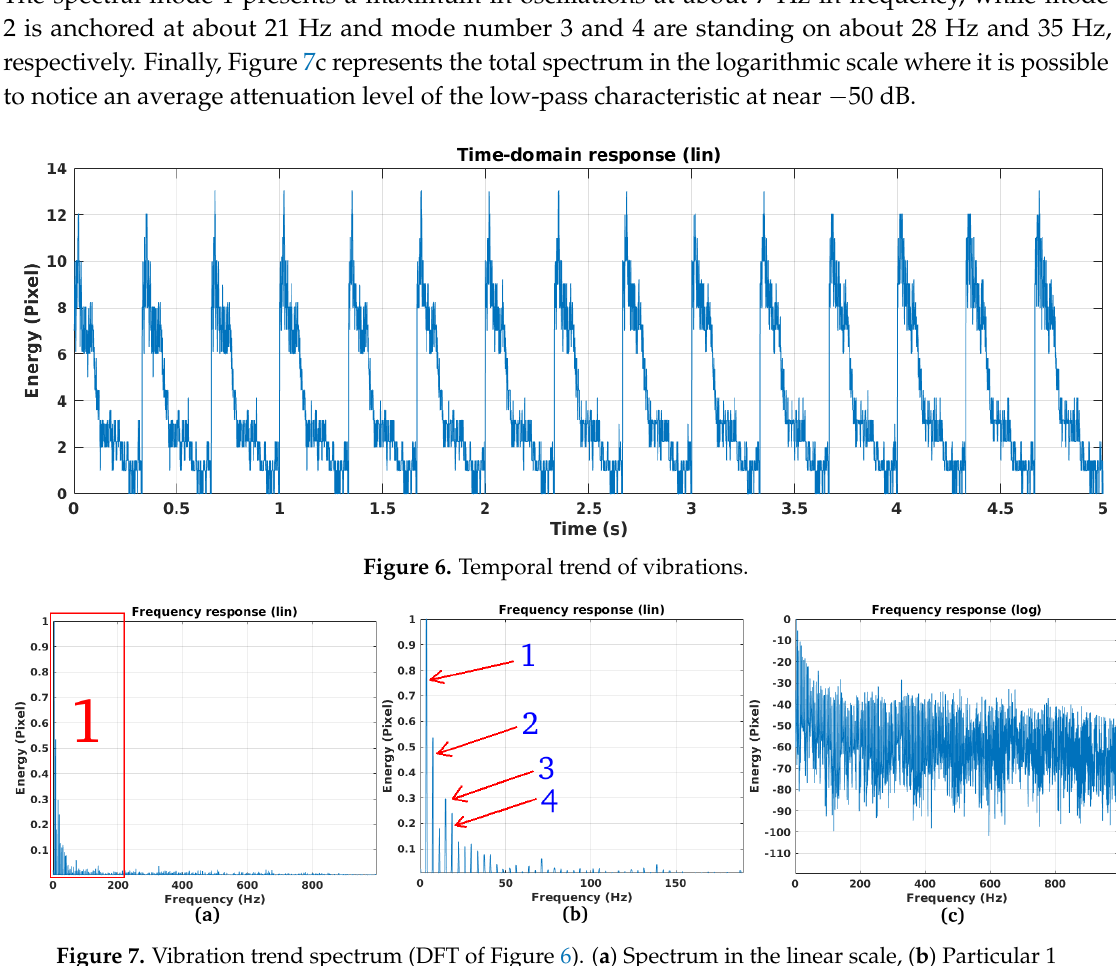
Figure 7. Vibration trend spectrum (DFT of Figure 6). ( a ) Spectrum in the linear scale, ( b ) Particular 1 of the spectrum trend ( a ), ( c ) Vibration spectrum in the logarithm